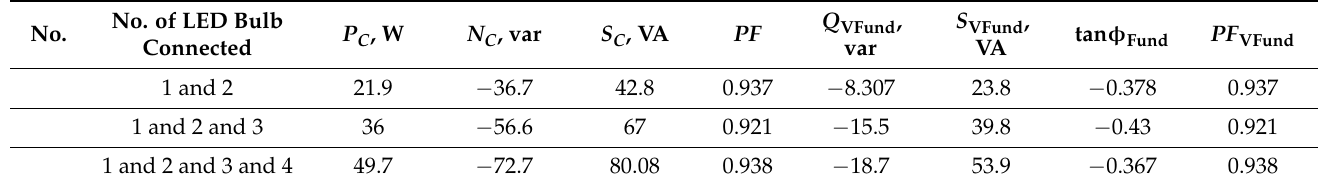
Table 3. The electrical parameters of the LED light bulbs combination connected to the PDL.